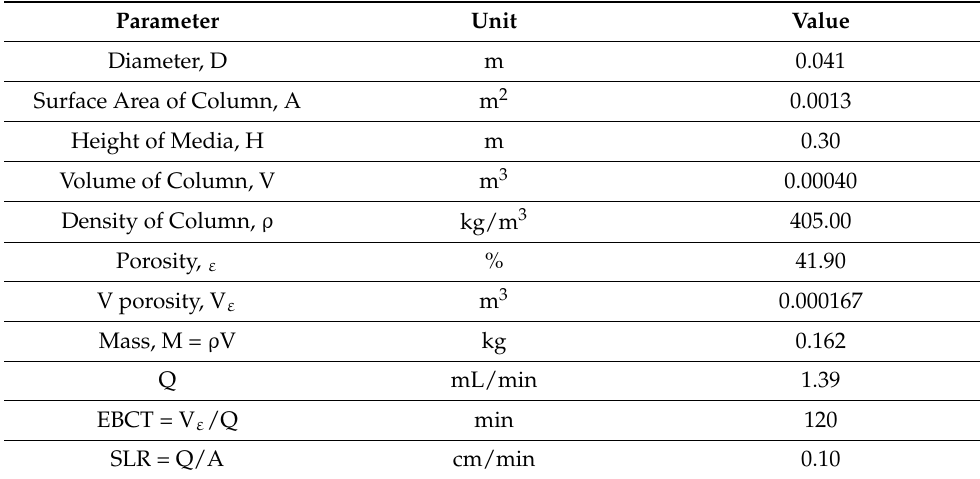
Table 1. Design of fixed bed adsorption parameters.